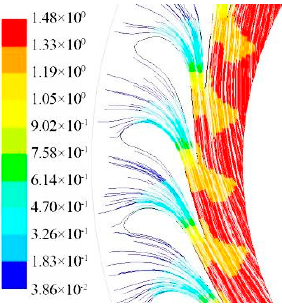
Figure 12. Streamlines in the stator blade with an installation angle of 28° and blade number 32.